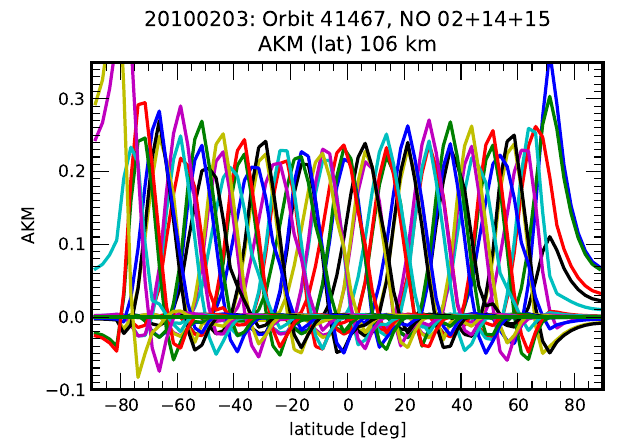
Fig. 8. Latitude averaging kernel matrix elements for a sample orbit (no. 41467, 3 February 2010).